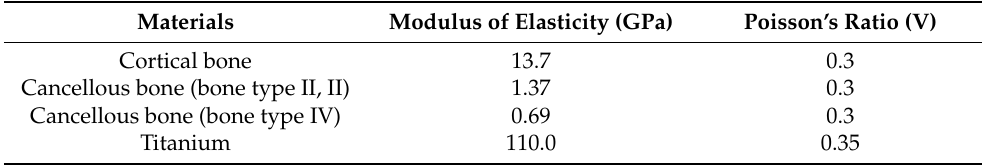
Table 1. Characteristics of the FEA models of various types of bone and titanium